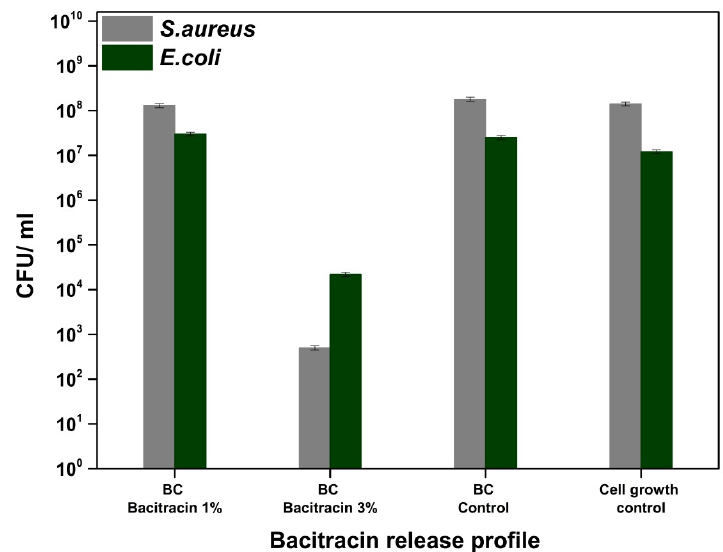
Figure 10. Graphical representation of CFU / mL values of Staphylococcus aureus ATCC 25923 and Escherichia coli ATCC 25922, in order to evaluate the bacitracin release from the BC-bacitracin samples into the broth media.